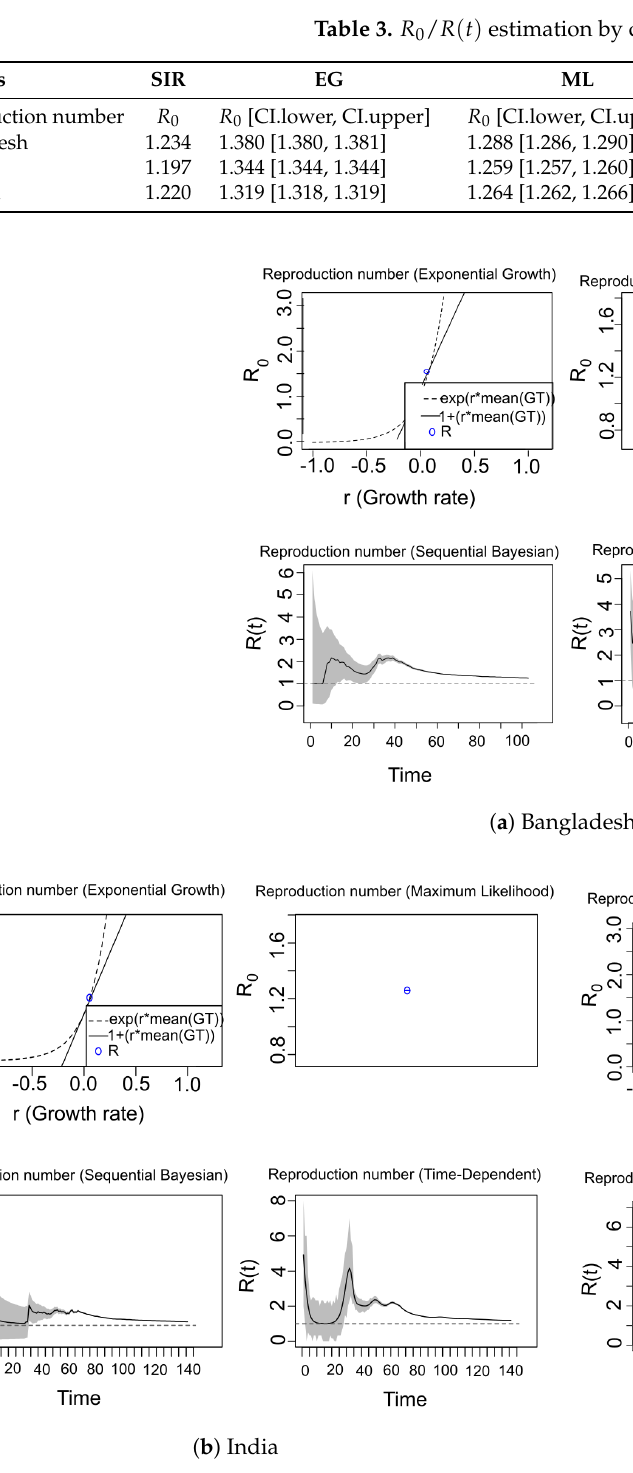
Figure 7. Estimate of the reproduction number R 0 − R ( t ) in Bangladesh, India and